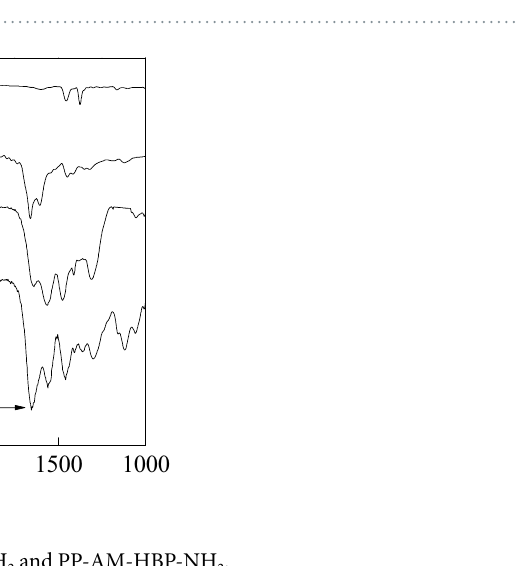
Figure 4. Nitrogen content and alkyl amino content of PP-AM-HBP-NH 2 prepared by using PP-AM with various grafting degree.